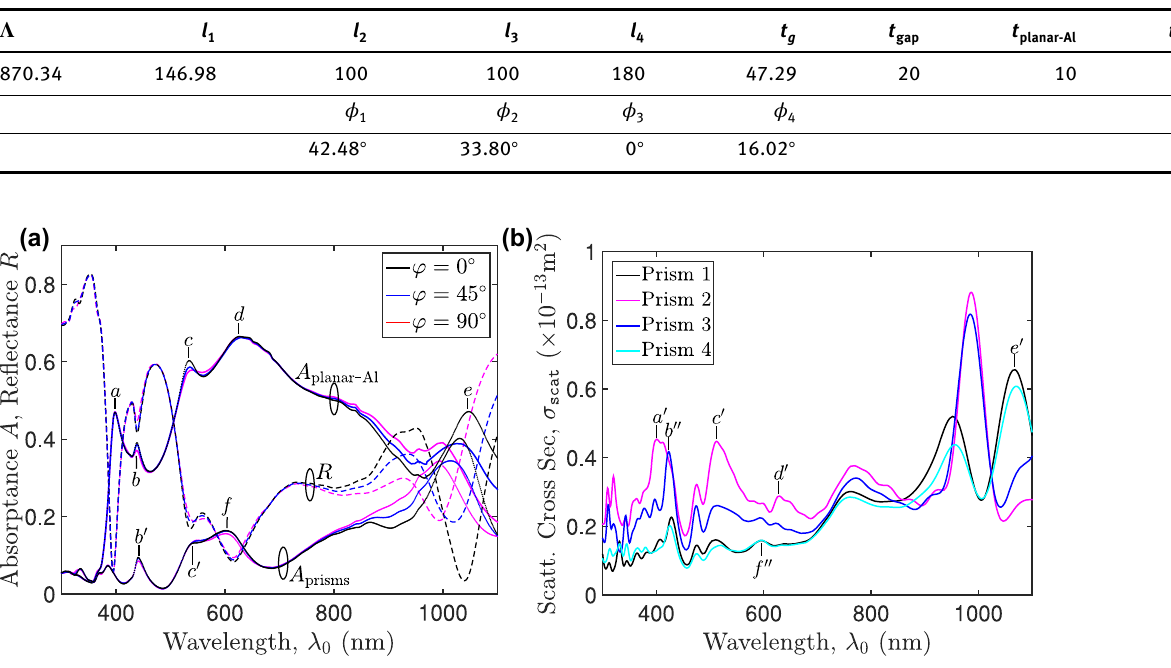
of each scat in planar − Al